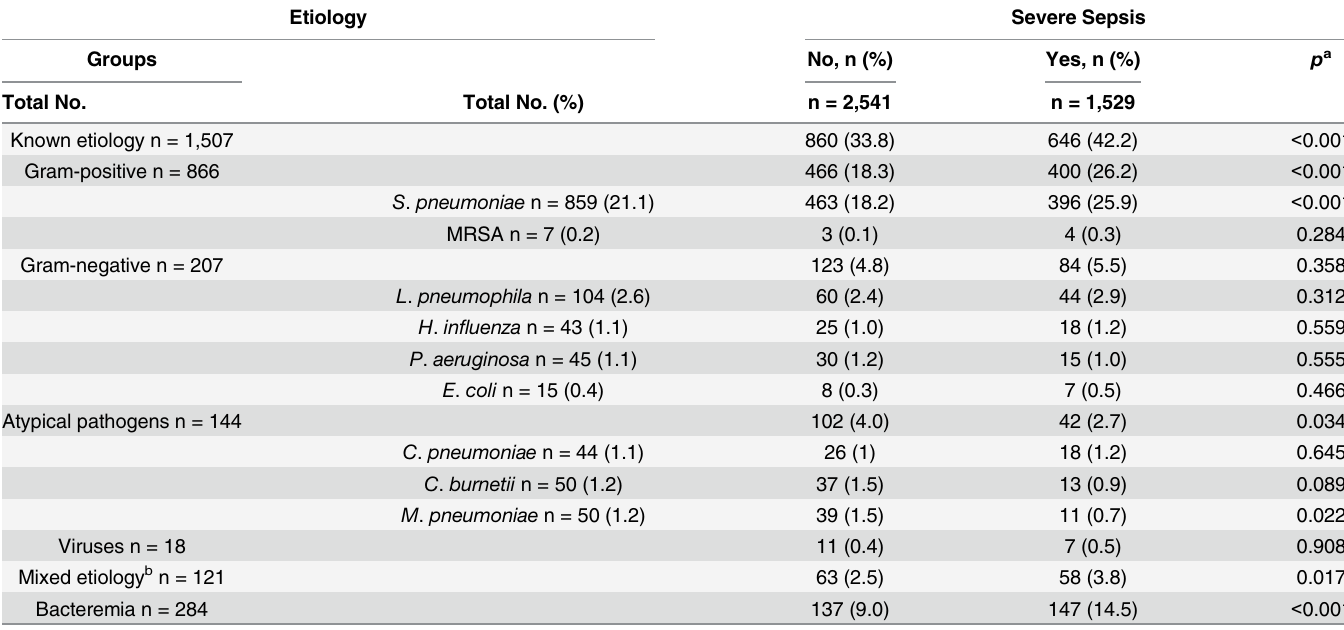
Table 3. Etiology of CAP in relation to severe